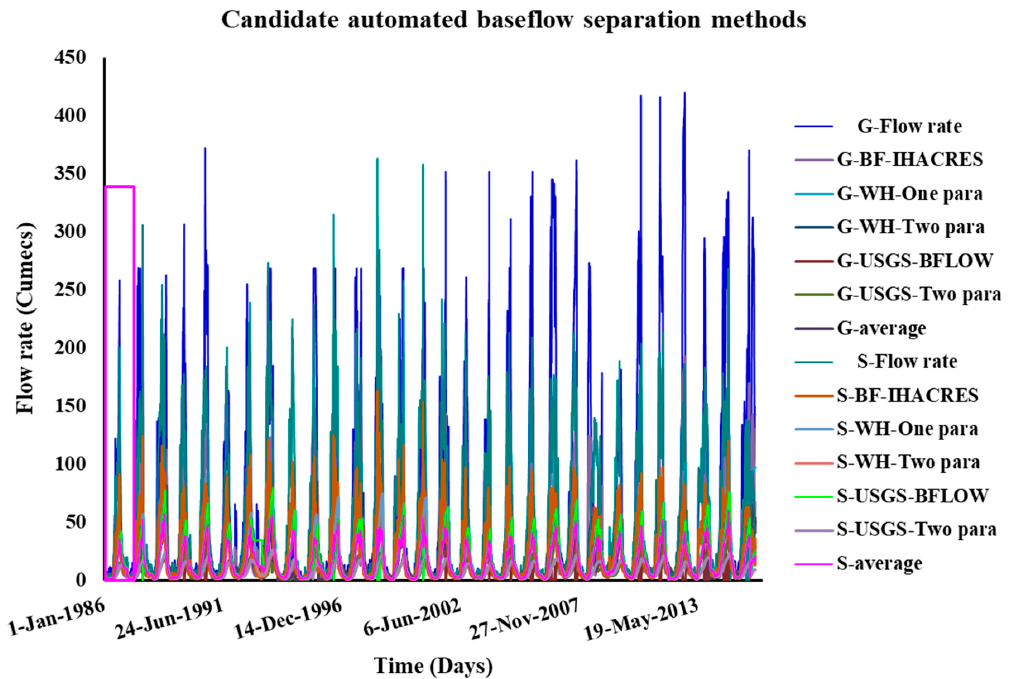
Figure 18. All candidate automated methods for use in the Sor and Gebba streams (Note: S is Sor, and G is Gebba). (The figure is compacted and difficult to understand. Therefore, a detailed one-year baseflow separation result is displayed in Figure 19. The graph of each technique is shown in Figure 20).